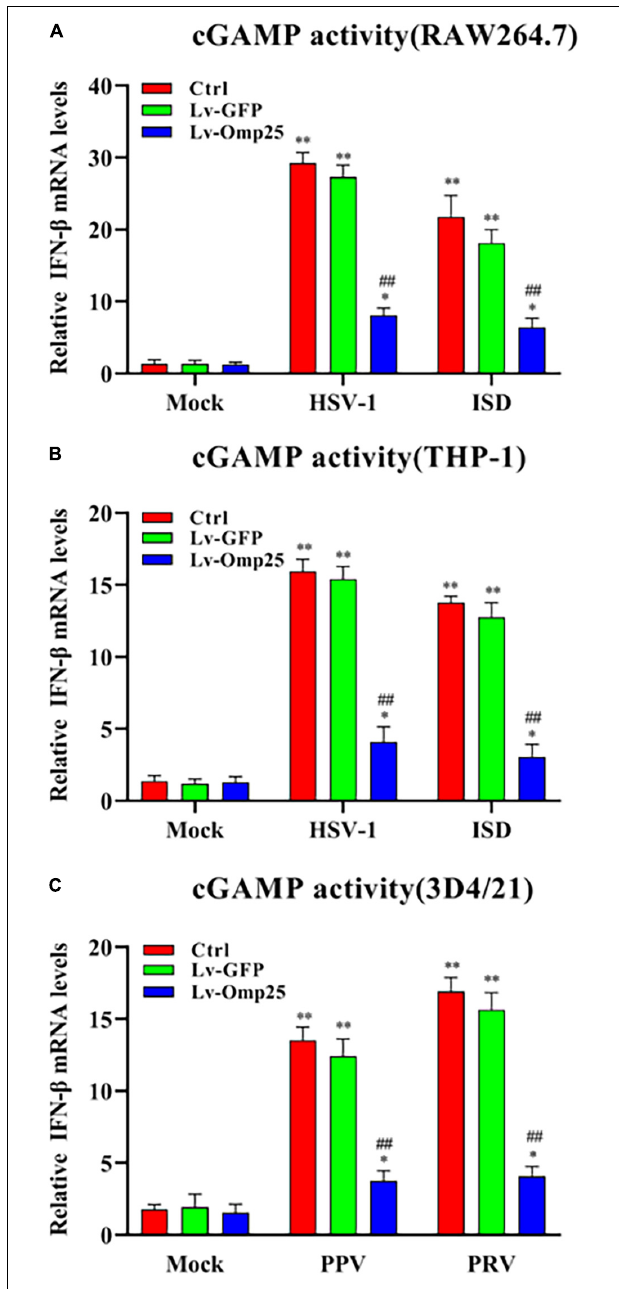
FIGURE 5 | Omp25 inhibits cGAS activity in human, murine, and porcine macrophages. (A,B) Omp25 inhibits cGAS activity in RAW264.7 or THP-1 cells. Cells were infected with Lv-Omp25 or Lv-GFP at an MOI of 100 for 48 h, then infected with HSV-1 (10 MOI) or stimulated by ISD (2 µ g/ml) another 6 h. Extracts from infected cells were prepared, DNase and heat-treated, and incubated with permeabilized RAW264.7 cells or THP-1 cells for 6 h. IFN- β RNA induction was analyzed by qRT-PCR and normalized to that of β -actin to assess levels of cGAMP in cell extracts. (C) Omp25 inhibits cGAS activity in porcine 3D4/21 cells. Cells were infected and treated as in panels (A,B) . Extracts from infected cells were prepared and incubated with permeabilized 3D4/21 cells for 6 h. IFN- β RNA induction was analyzed by qRT-PCR. * P < 0.05, ** P < 0.01 versus mock group, # P < 0.05, ## P < 0.01 versus Lv-GFP-infected cells in same